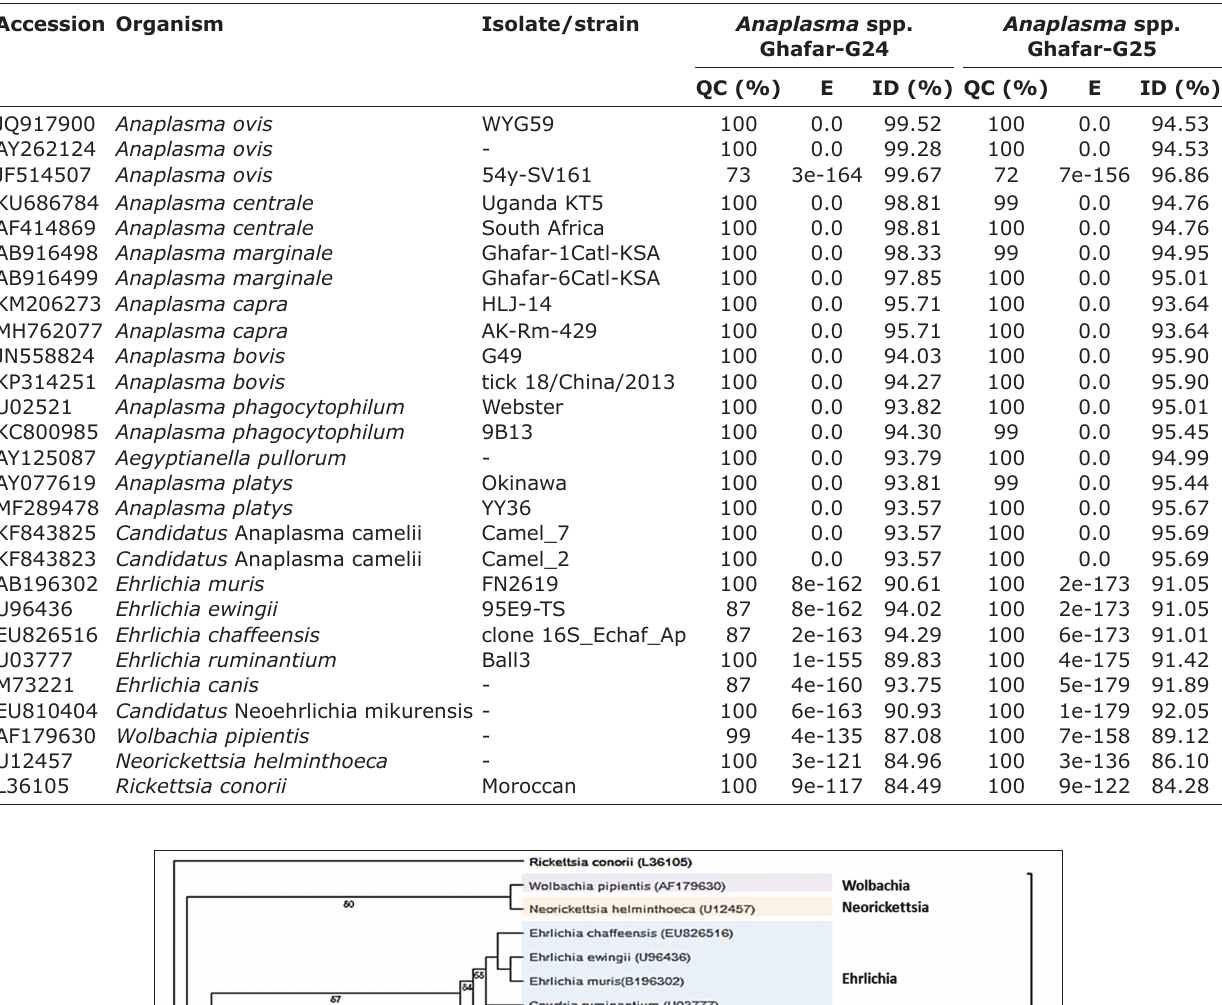
Table-1: Similarity features of the detected Anaplasma organisms to recognized species used in the phylogenetic tree. (Accessed March 16, 2019). Accession Organism